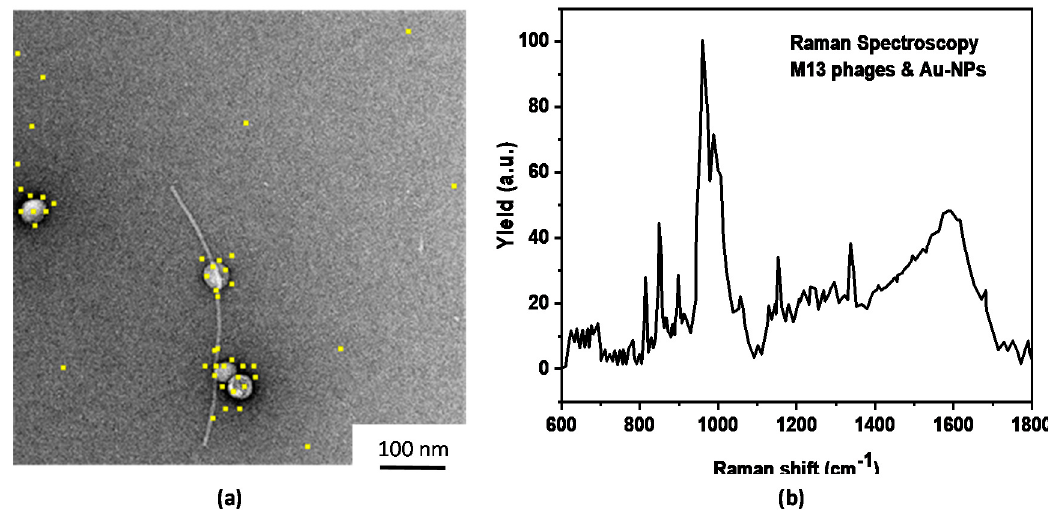
Figure 5. Characteristic X-ray image of the Au L lines in the TEM underlayer image ( a ) and typical Raman spectrum of the solution containing the M13 phages with Au NPs ( b ).